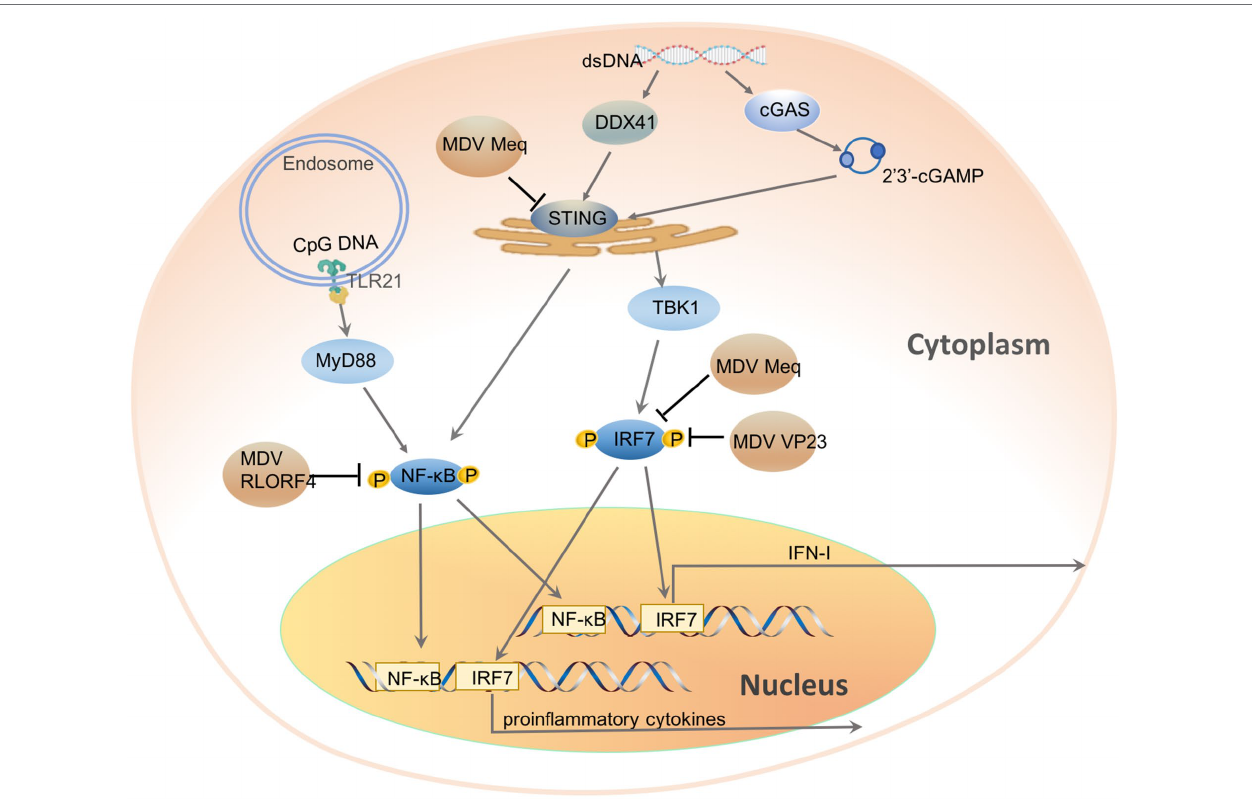
FIGURE 1 | Chicken DNA viruses’ evasion of DNA sensor-induced antiviral innate immunity. cGAS and DDX41 localize in the cytoplasm and sense cytosolic dsDNA directly, DNA recognition induces cGAS and DDX41 activation. Upon activation, cGAS catalyzes the synthesis of the nucleotide 2'3'-cGAMP from ATP and GTP, which will be bound by STING and induce STING activation, while DDX41 interacts and activates STING directly. STING activation recruits and activates TBK1, followed by phosphorylation and nuclear translocation of transcription factor IRF7, which initiates transcription of IFN-I and pro-inflammatory cytokines. STING